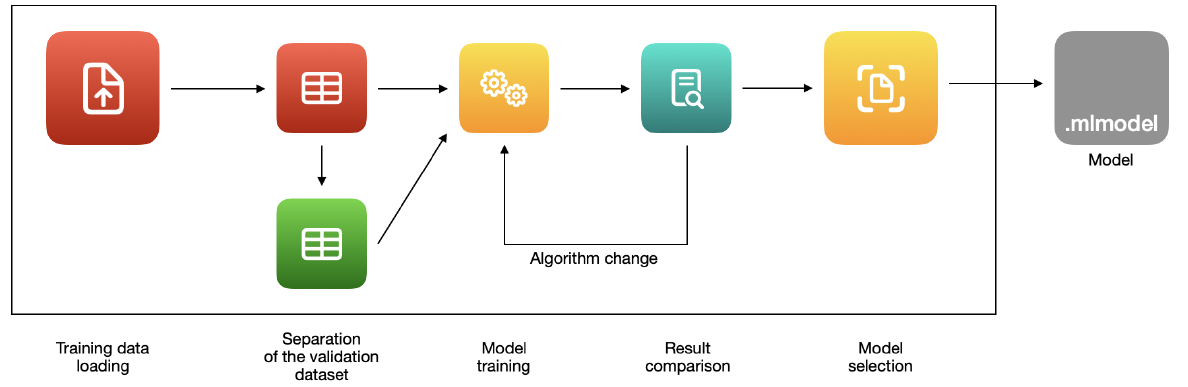
Figure 5. The stages of training a tabular classifier with ‘Create